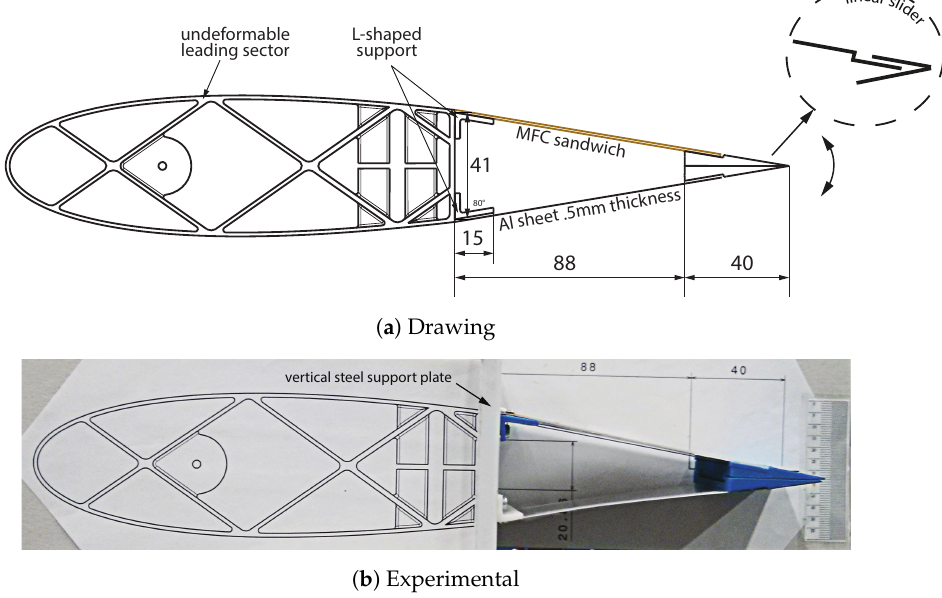
Figure 2. Side view of the actuator (dimensions in